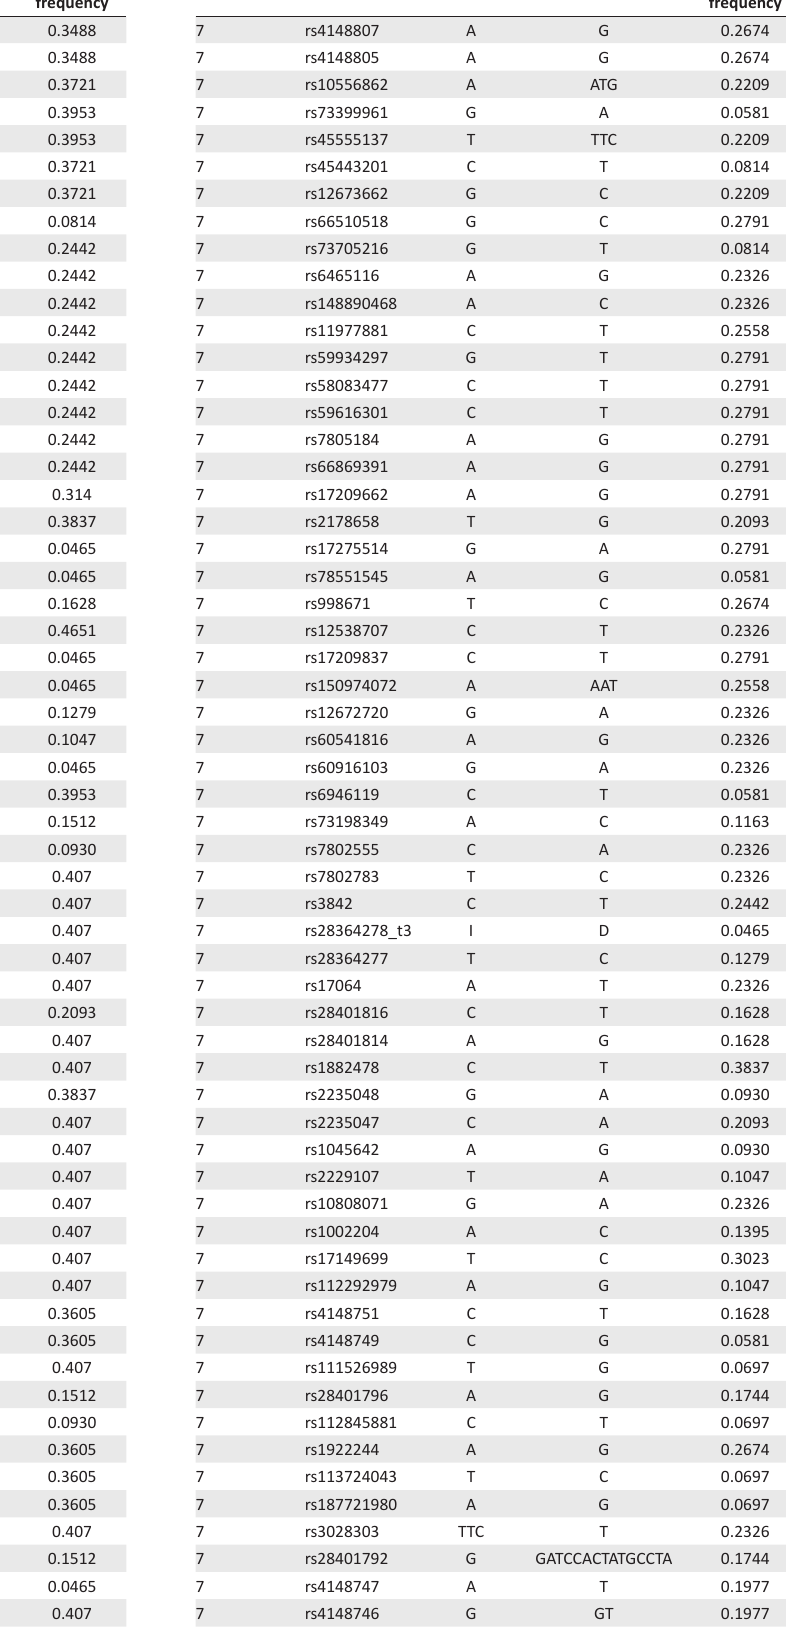
Table 1-A1 (Continues...): Minor allele frequencies for 1846 polymorphisms in 43 black South Africans. Chromosome Polymorphism Minor allele